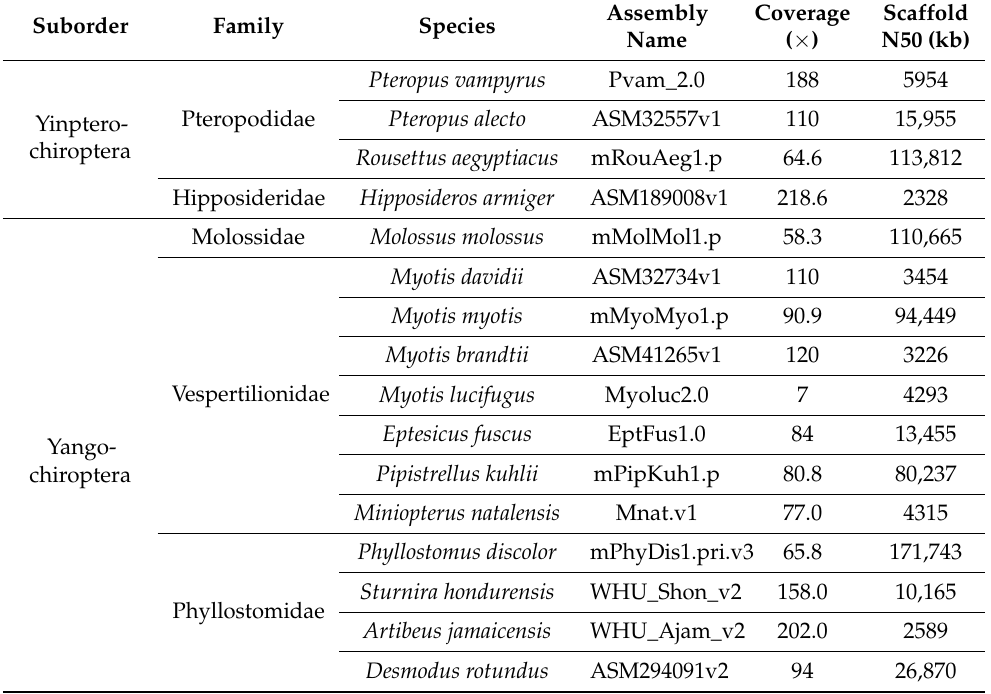
Table 1. Information of bat genome